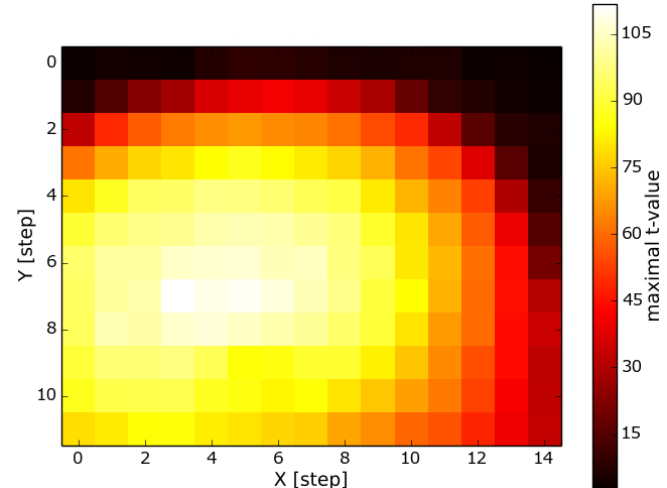
Figure 12: Maximum of t-value trace per position on a 50 µm grid using a 150 µm diameter